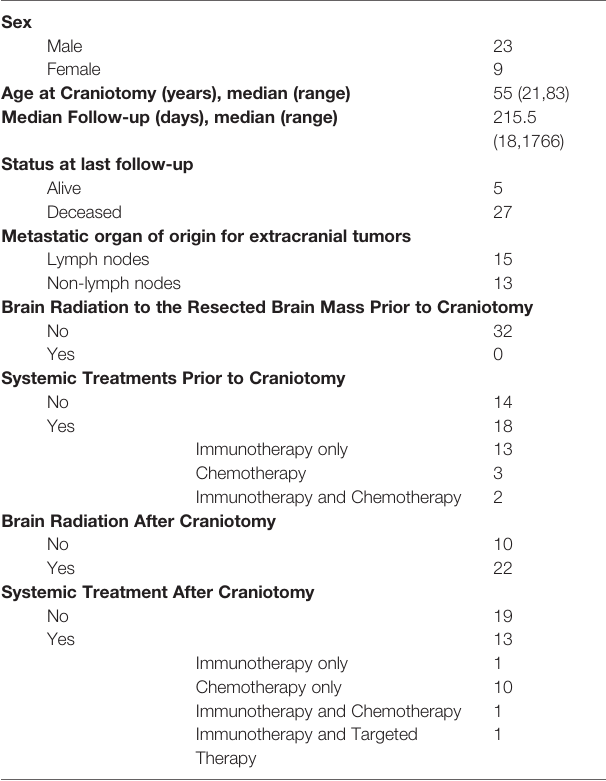
did. See Supplementary Figure 1 from Hamilton et al. Cancer 2013, PMID 23695963, for